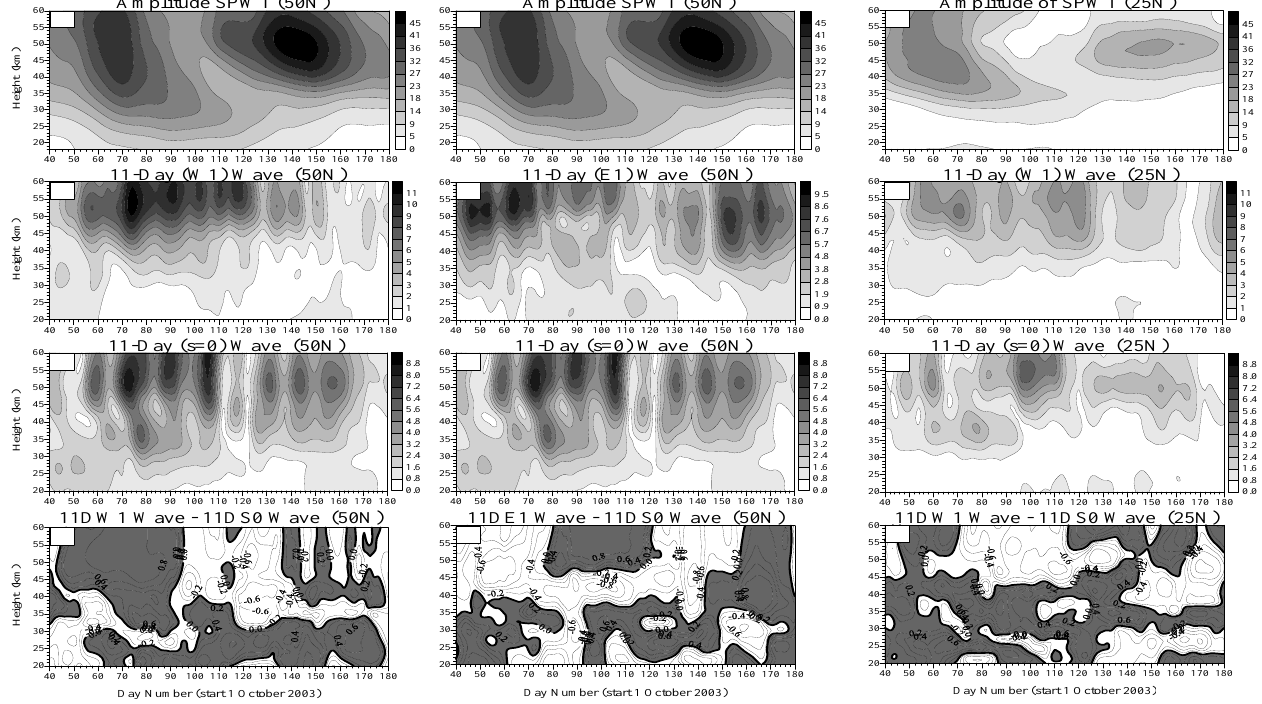
Fig. 8. The same as Fig. 7 but for the ∼ 11-day W1 and ∼ 11-day E1 primary waves and ∼ 11-day ( s =0) secondary Figure 8